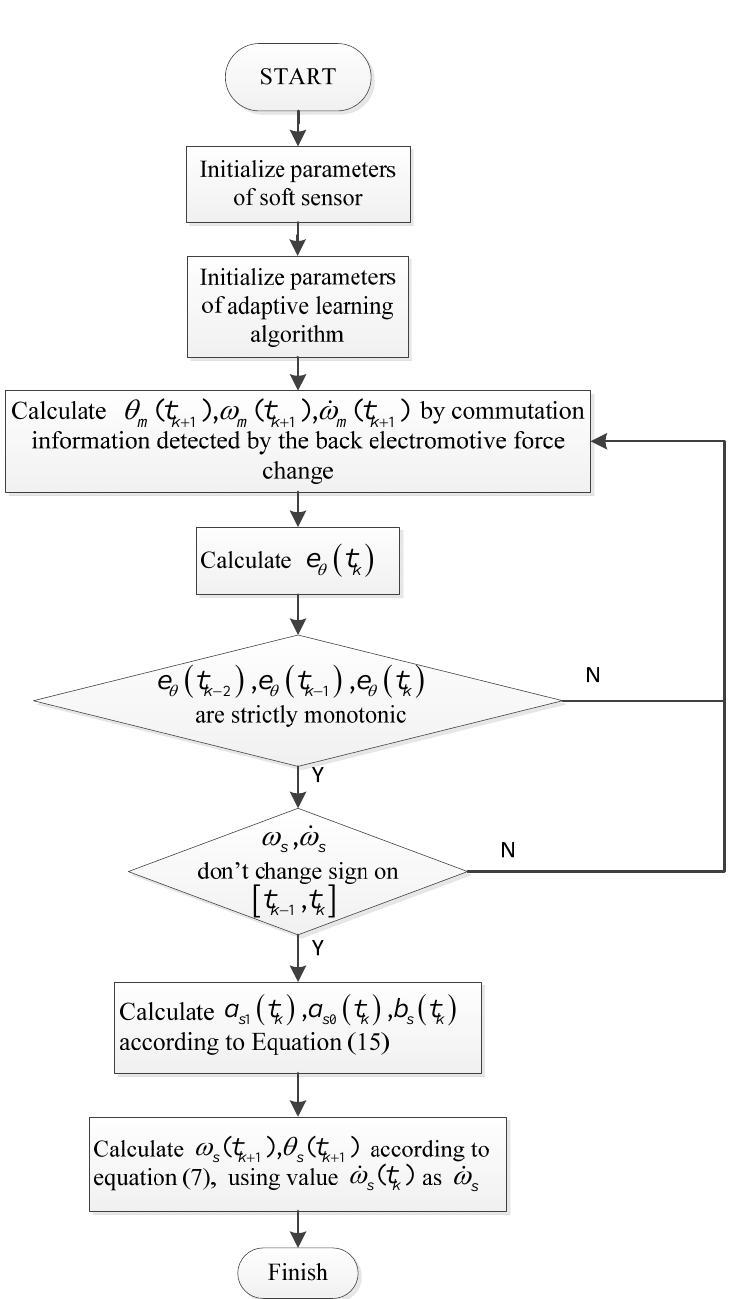
Figure 3. The flowchart of the one ‐ step ‐ delay adaptive learning algorithm.